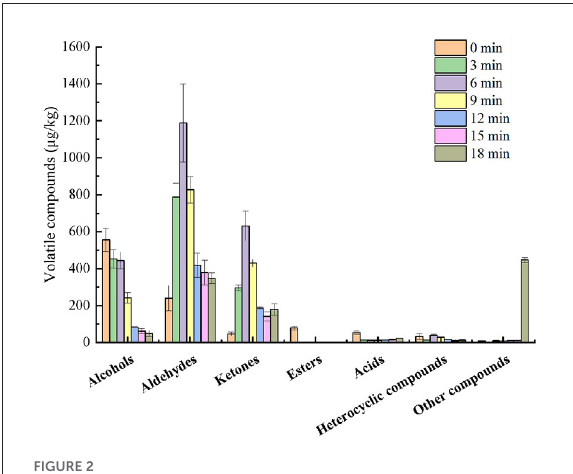
FIGURE2 Categories and concentrations of the major volatile compounds in the roasted